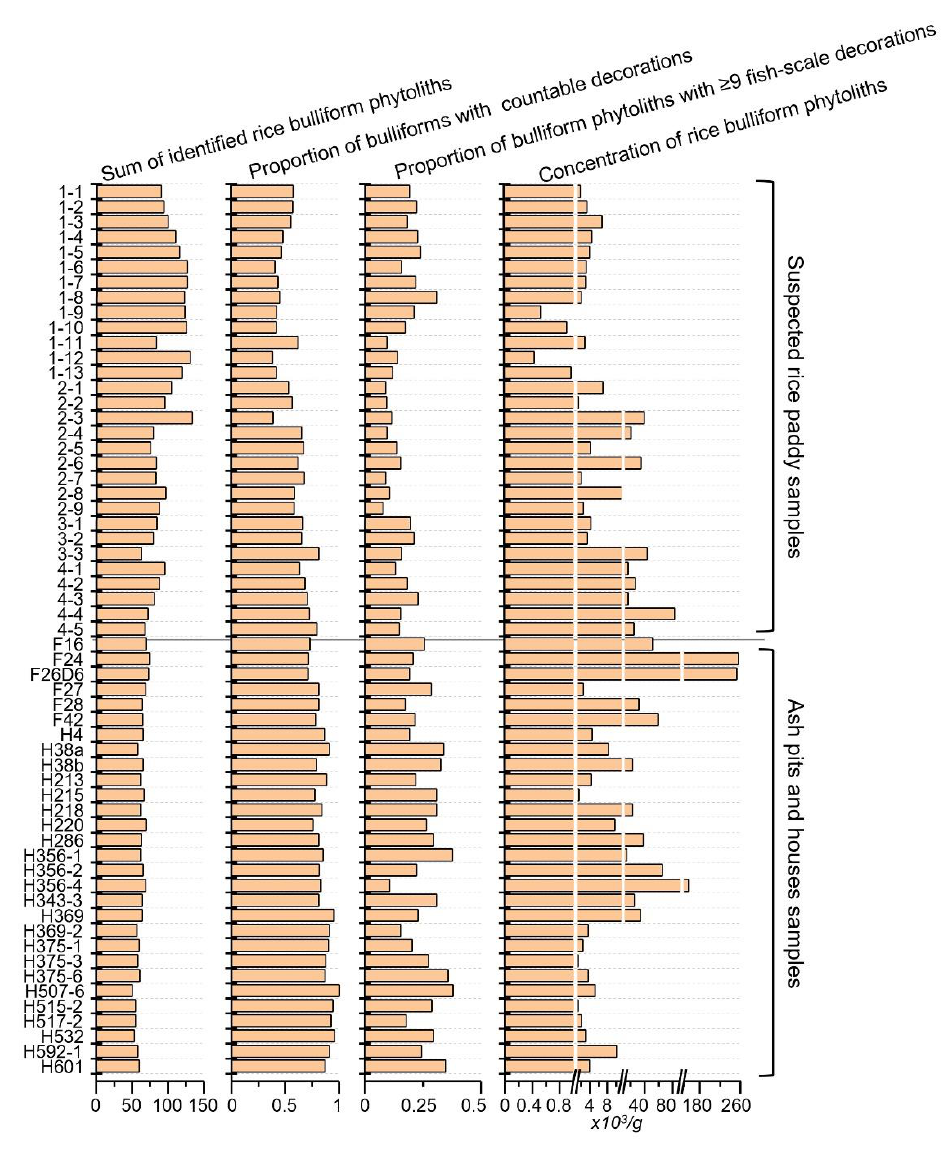
Figure 6. Results of rice bulliform phytoliths at Zhangwangzhuang.